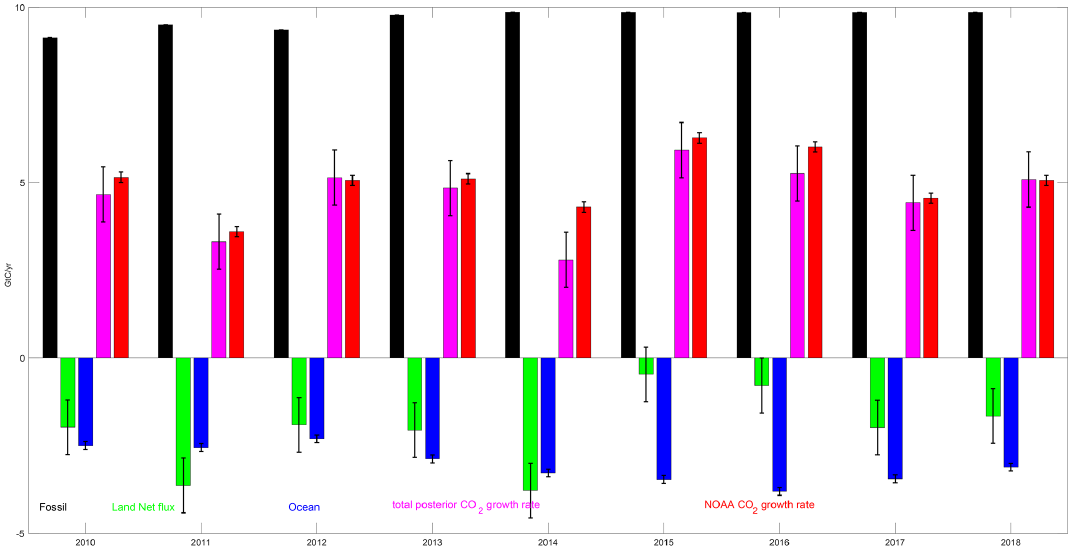
Figure 4. Global flux estimation and uncertainties from 2010–2018 (black: fossil fuel; green: posterior land fluxes; blue: ocean fluxes; magenta: estimated CO 2 growth rate; red: the NOAA CO 2 growth